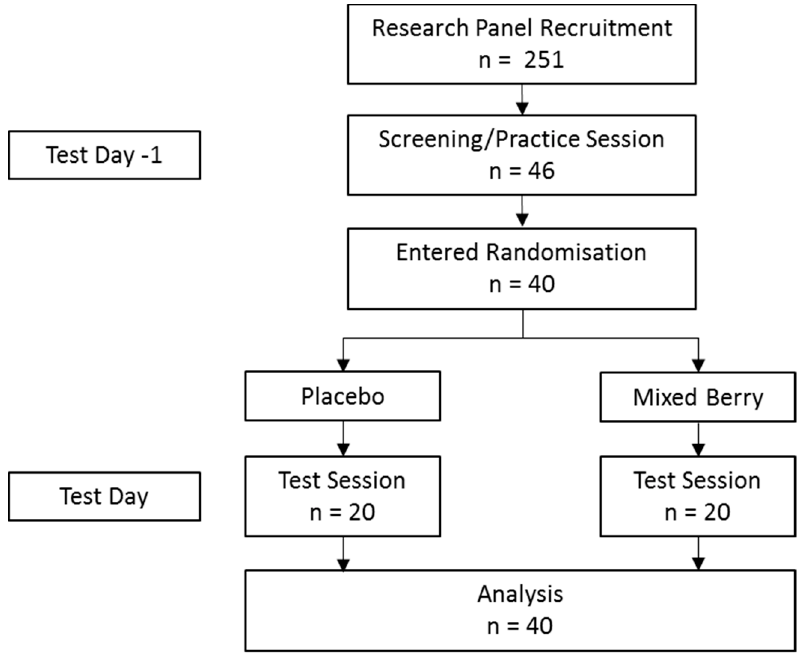
Figure 1. Intervention allocation and participant numbers throughout study.